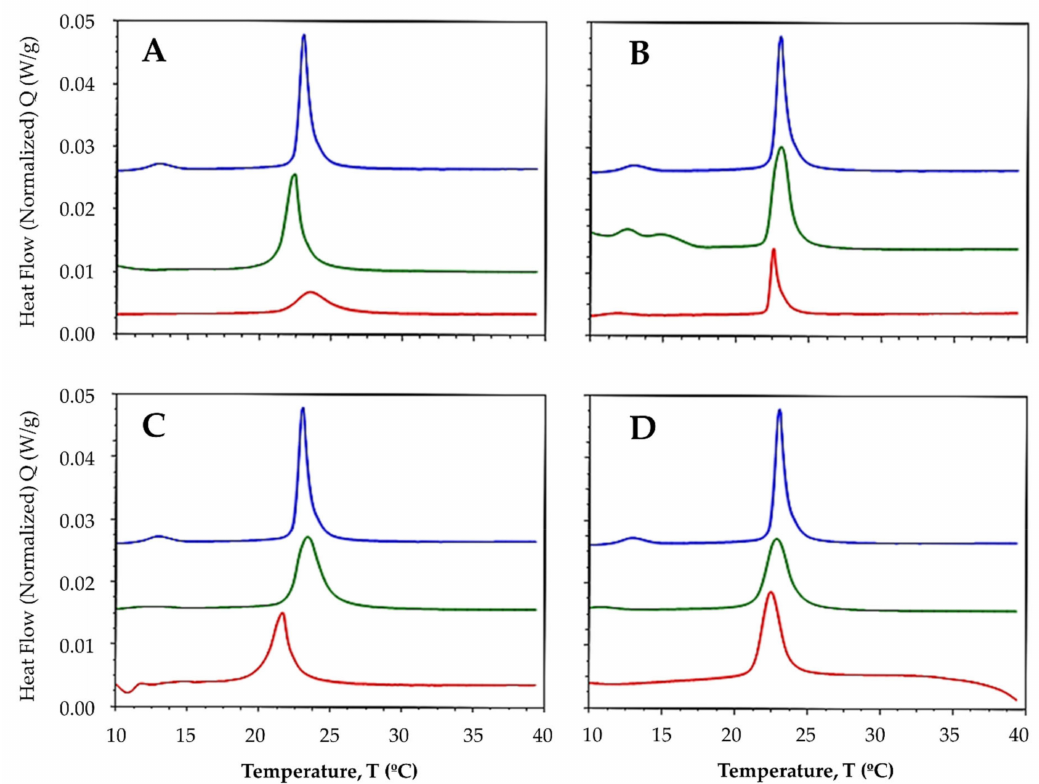
Figure 4. DCS thermograms from MLVs made up of DMPC/DMPG mixture before ( ---- ) and after adding the ligand ( ---- ) and the La complex ( ---- ) in a 1:50 compound-lipid molar ratio. ( A ) L1; ( B ) L2; ( C ) L3; and ( D ) L4.